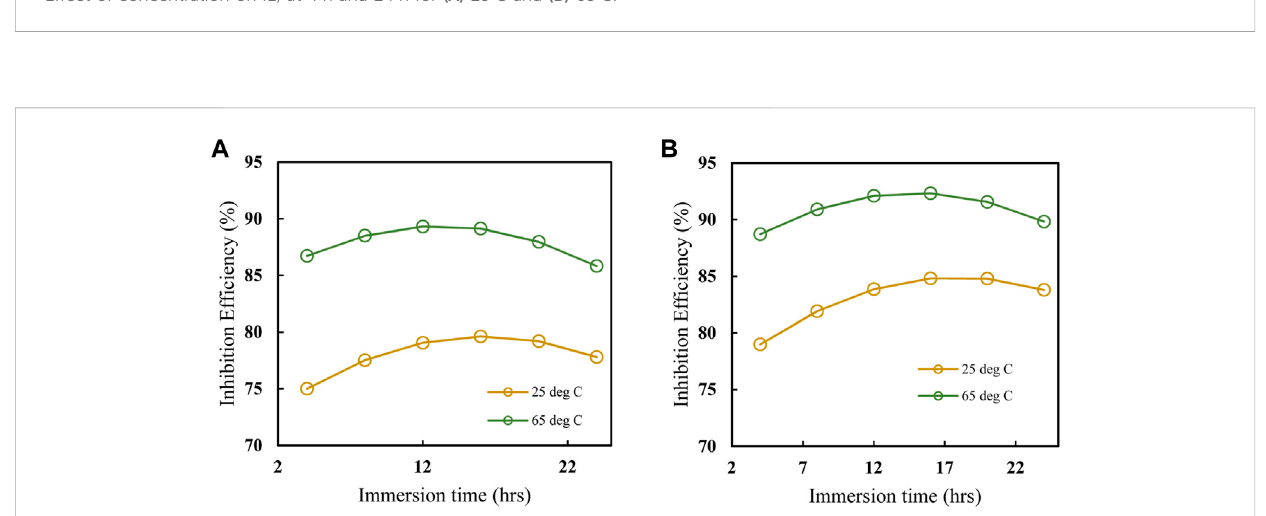
FIGURE 14 Effect of immersion time on IE, at 25 ° C & 65 ° C for (A) 100 and (B) 500 ppm.